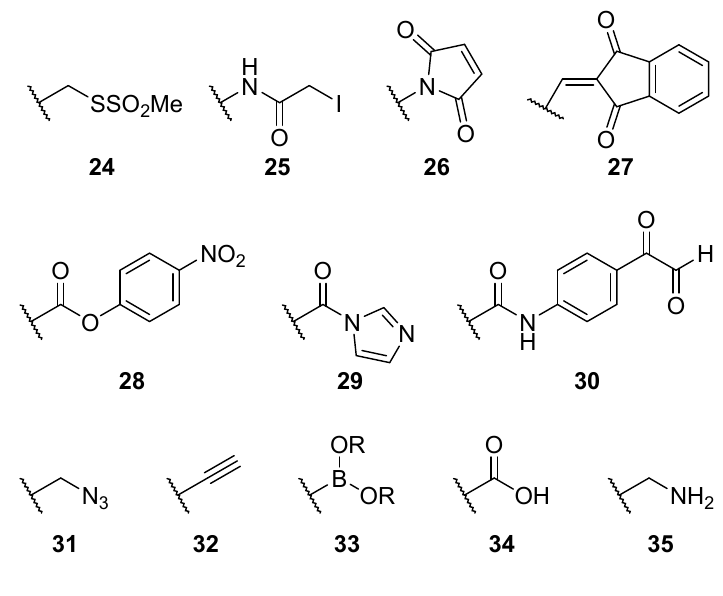
Figure 4. Structures of common nitroxide